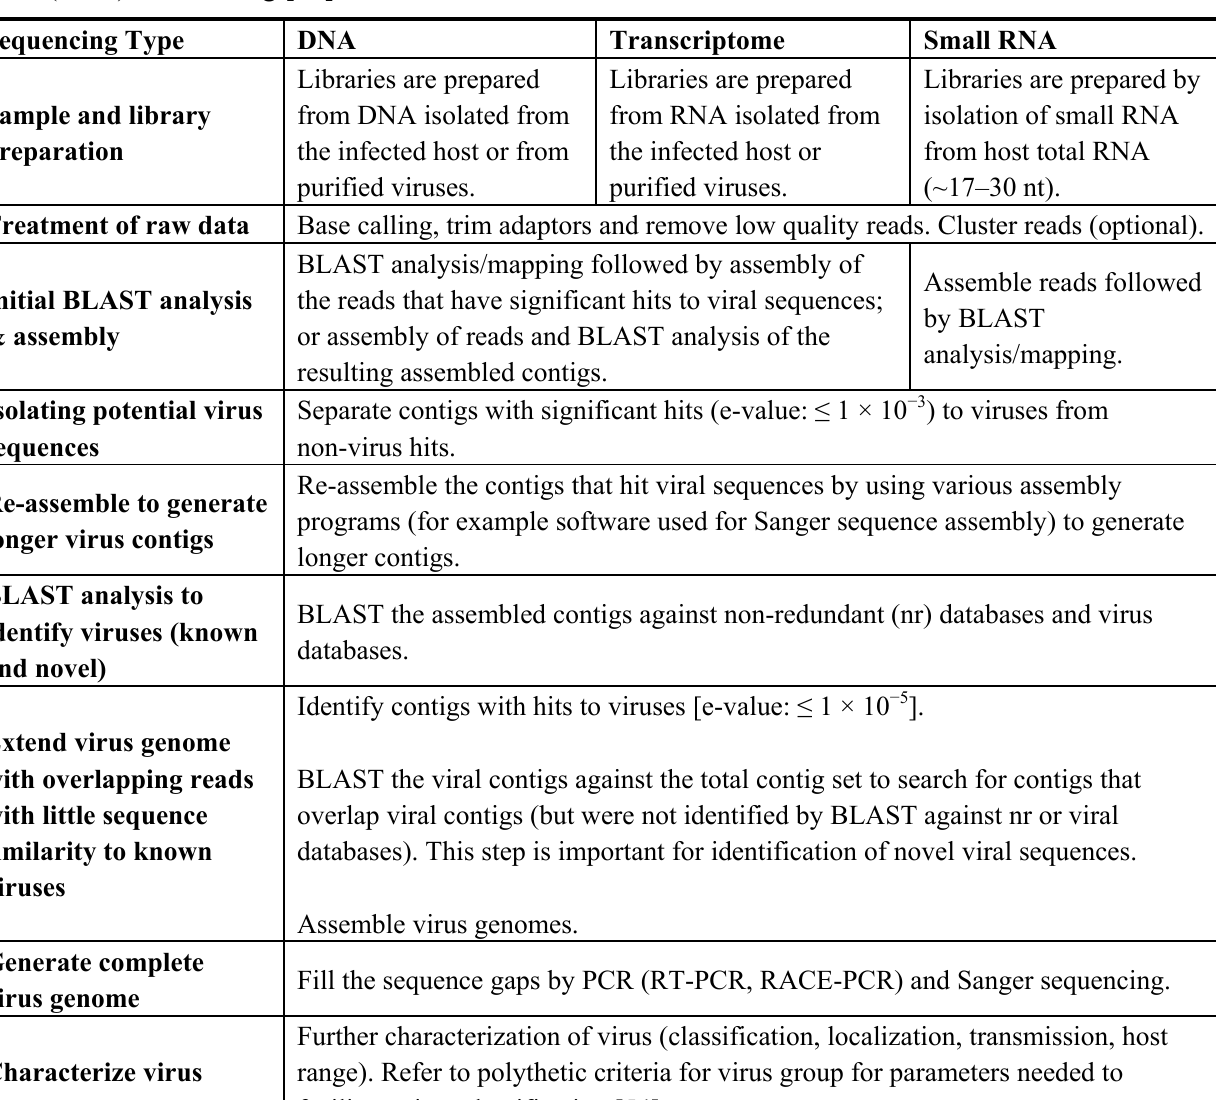
Table 2. Bioinformatics methods used for virus discovery by Next Generation Sequencing (NGS) data mining